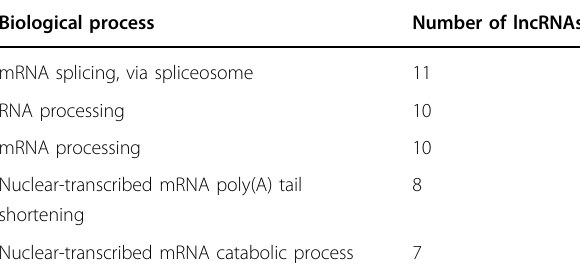
Table 3 Functional ontology of long noncoding RNAs (lncRNAs) altered in alcohol use